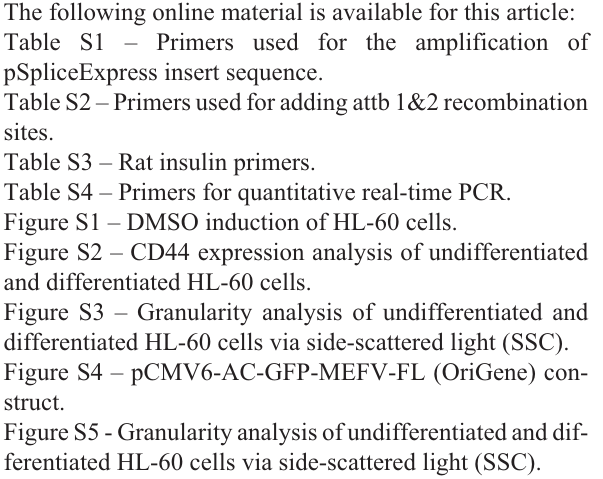
Figure S1 – DMSO induction of HL-60 cells. Figure S2 – CD44 expression analysis of undifferentiated and differentiated HL-60 cells. Figure S3 – Granularity analysis of undifferentiated and differentiated HL-60 cells via side-scattered light (SSC). Figure S4 – pCMV6-AC-GFP-MEFV-FL (OriGene) con- struct. Figure S5 - Granularity analysis of undifferentiated and dif- ferentiated HL-60 cells via side-scattered light